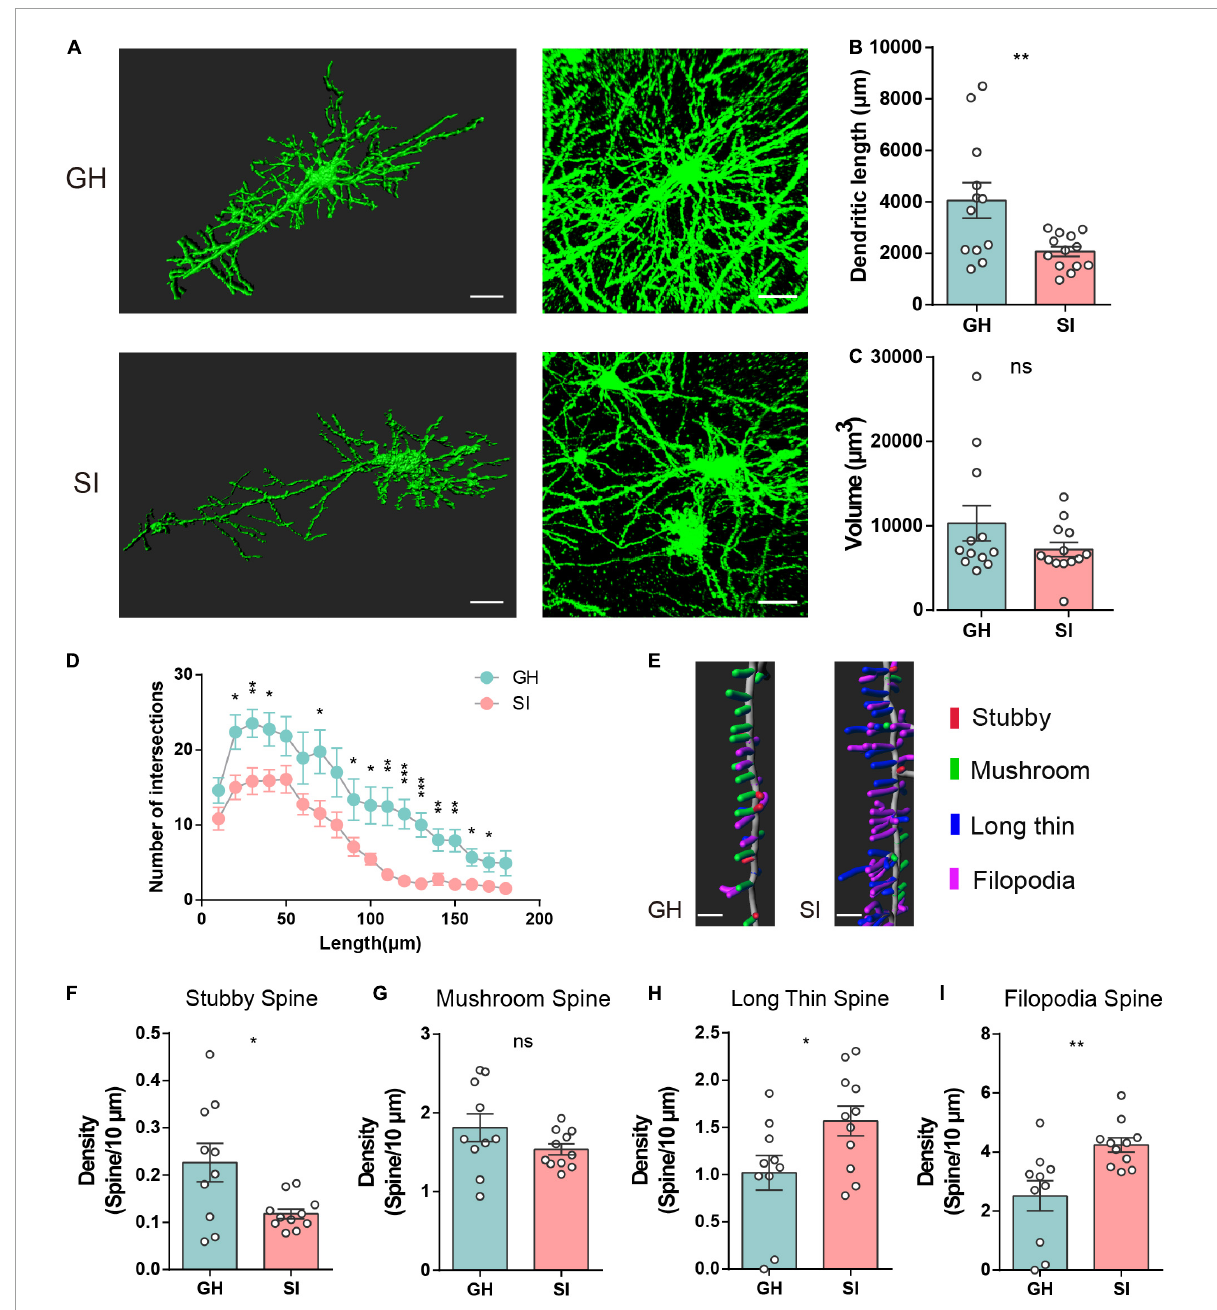
FIGURE2 Impacts of adolescent social isolation on the structure of dendrites and spines of pyramidal neurons in the mPFC. (A) Representative reconstructed (left) and raw (right) images of pyramidal neurons in the PL and IL regions of GH- and SI-treated mice. Scale bars, 30 µ m, left; 50 µ m, right. In the adolescent-GH group, 4 neurons in layer 2/3 and 8 neurons in layer 5 from 3 mice were used; in the adolescent-SI group, 5 neurons in layer 2/3 and 8 neurons in layer 5 from 3 mice were used. (B,C) Summary of dendritic length (B) and volume (C) of PL and IL pyramidal neurons obtained from the experimental mice (GH, n = 12; SI, n = 13, dendrite length, GH, 4055 ± 690.9, SI, 2067 ± 188.4, two-tailed unpaired t test: P < 0.01; volume, GH, 10309 ± 2068, SI, 7196 ± 850.3, two-tailed Mann–Whitney test P = 0.40). (D) Sholl analysis of dendritic branching complexity in the basal and apical dendrites of the two groups of mice. (GH, n = 13; SI, n = 13; * P < 0.05, ** P < 0.01 and *** P < 0.001 determined by two-tailed unpaired t test or Mann–Whitney test). (E) Representative confocal 3D reconstruction images of dendritic spines of PL or IL pyramidal neurons obtained from GH and SI mice. Scale bars, 5 µ m. (F–I) Summary of the density of stubby- (F) , mushroom- (G) , long thin- (H) , and filopodia- (I) shaped spines on the dendrites of pyramidal neurons in the PL and IL regions of GH and SI mice. (GH, n = 10, SI, n = 11, two-tailed unpaired t test: stubby spines, GH, 0.23 ± 0.04, SI, 0.12 ± 0.01, P < 0.05; mushroom spines, GH, 1.81 ± 0.18, SI, 1.54 ± 0.07, P = 0.15; long thin spines, GH, 1.02 ± 0.18, SI, 1.57 ± 0.16, P < 0.05; filopodia spines, GH, 2.52 ± 0.51, SI, 4.24 ± 0.23, P < 0.01). Data are presented as the mean ± SEM. GH: group-housed; SI: social